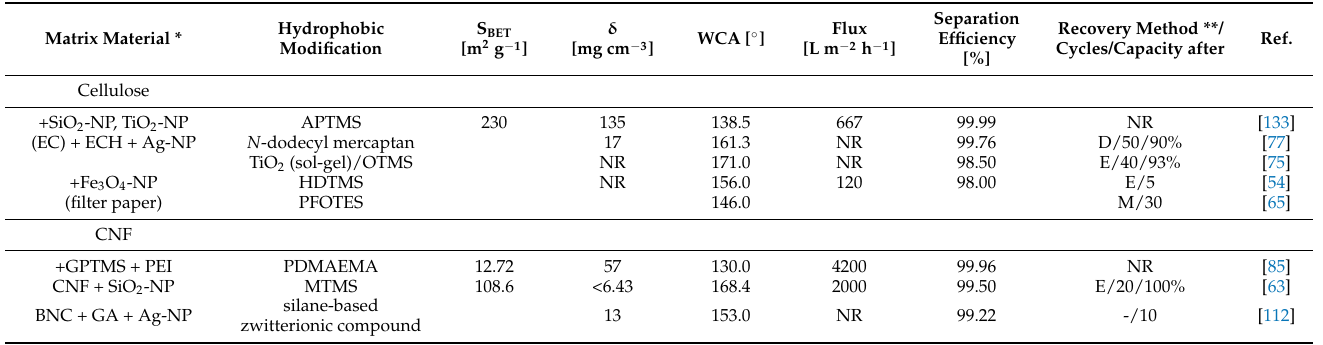
Table 2. Hydrophobic aerogels used as filters.